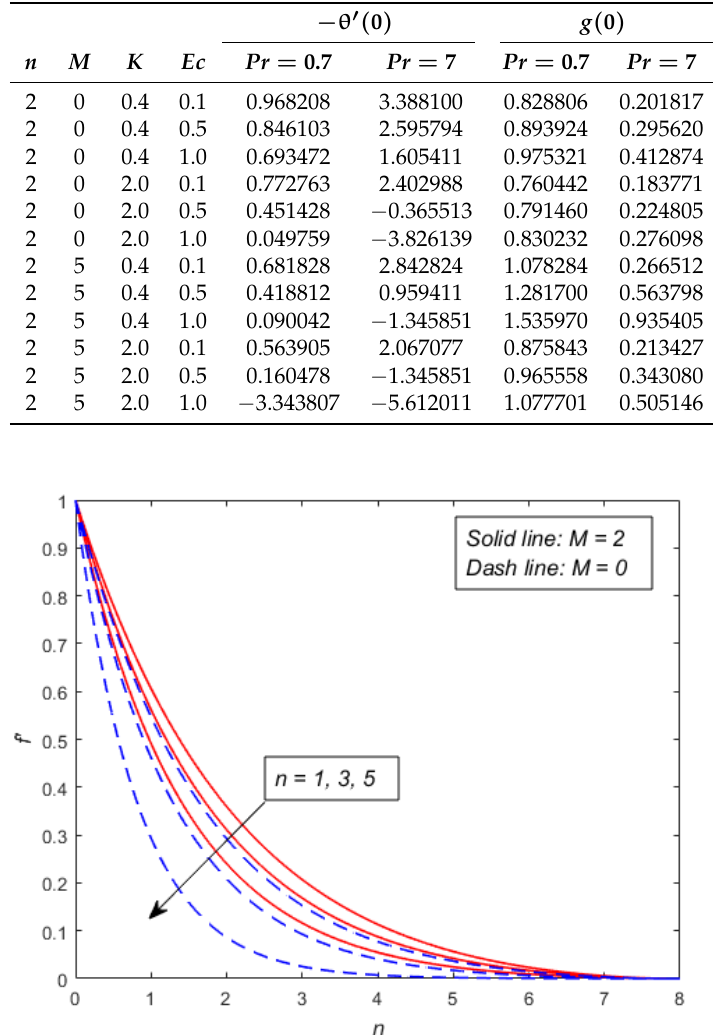
Table 4. Variation of the numerical values for the rate of heat transfer − θ (cid:48) ( 0 ) and the wall temperature g ( 0 ) for PST- and PHF cases for different values of n , M , K , Ec , and Pr .